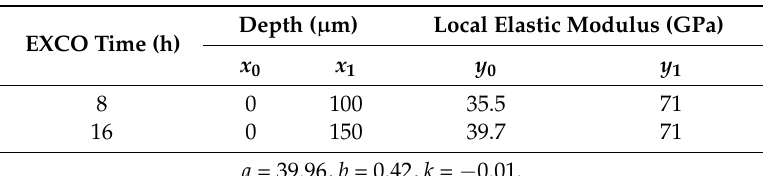
Table 2. Input data for the estimations of the exponential evolution of HEZ’s local elastic modulus after 8 and 16 h in EXCO solution.